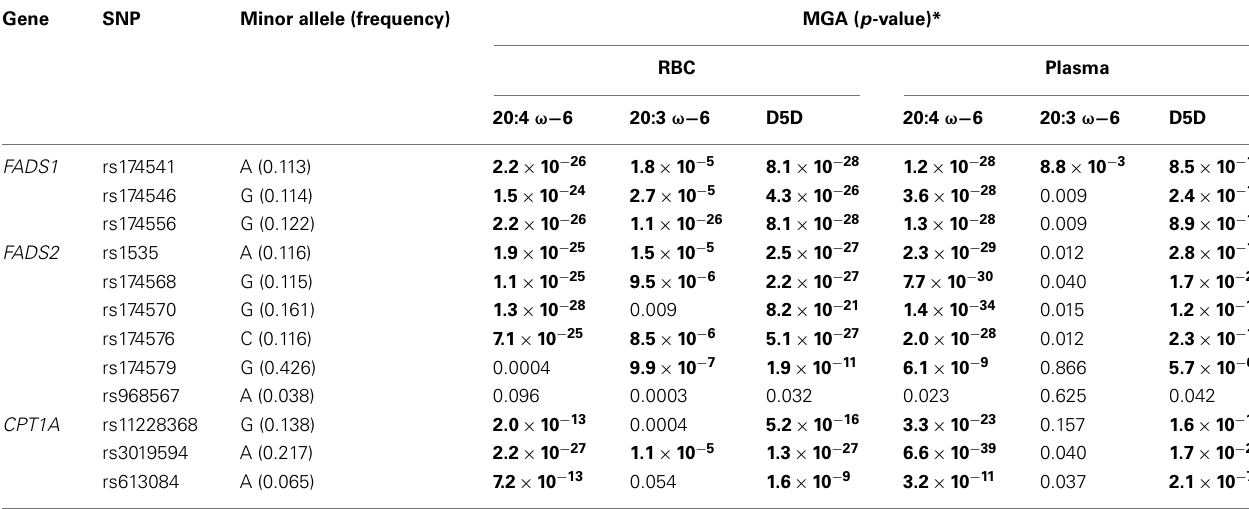
Table 2 | Measured genotype association results for SNPs most significantly associated with D5D.